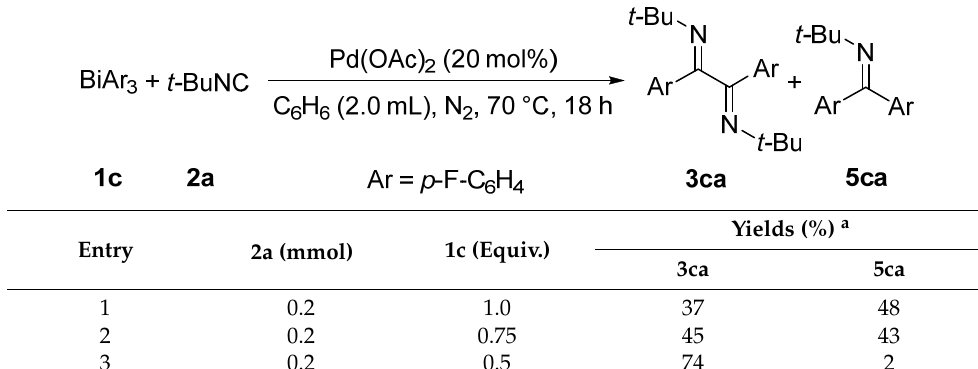
Table 3. Pd-catalyzed diarylation of t -BuNC with Bi(C 6 H 4 -F- p ) 3 .